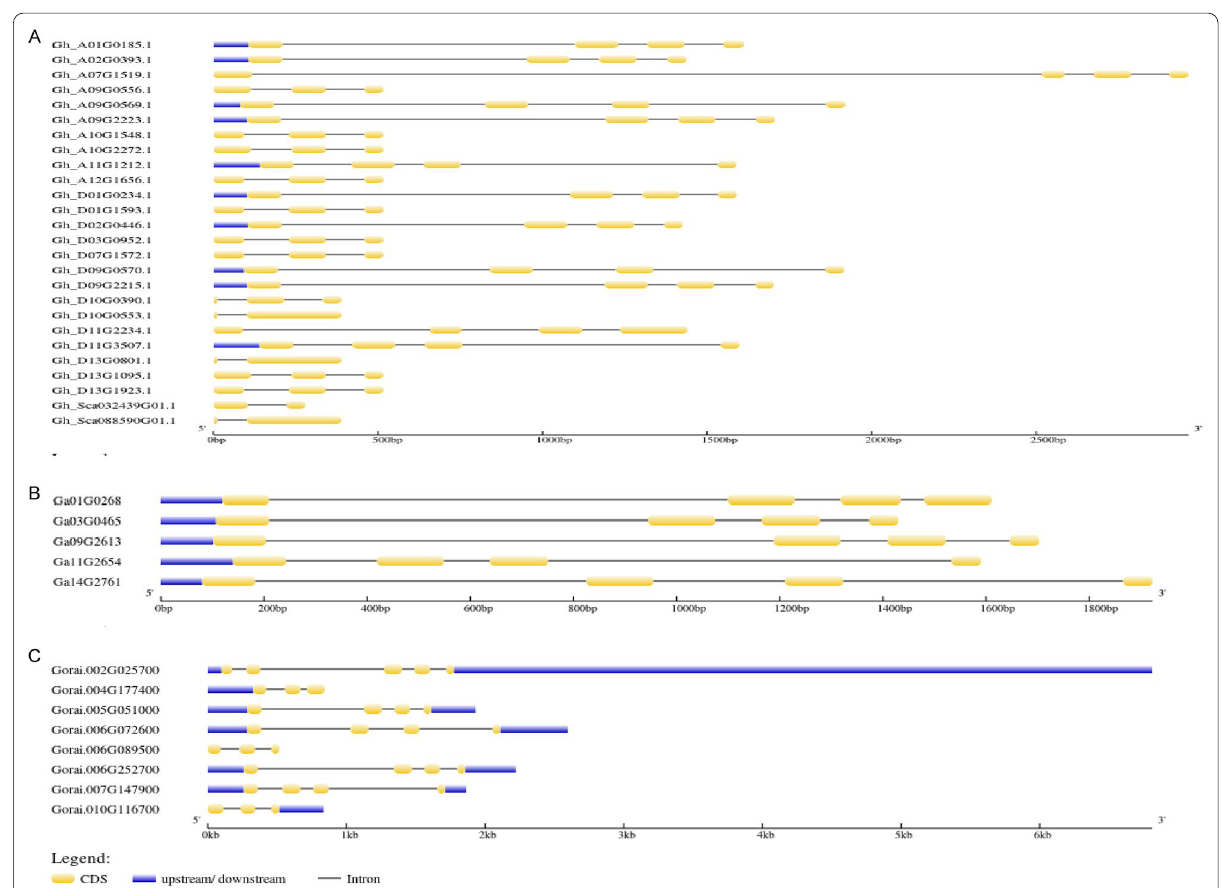
Fig. 3 Gene structure of cotton RPL14B proteins. A Gene structure of genes in G. hirsutum , B gene structure of G. arboreum genes, C gene structure of G. raimondii